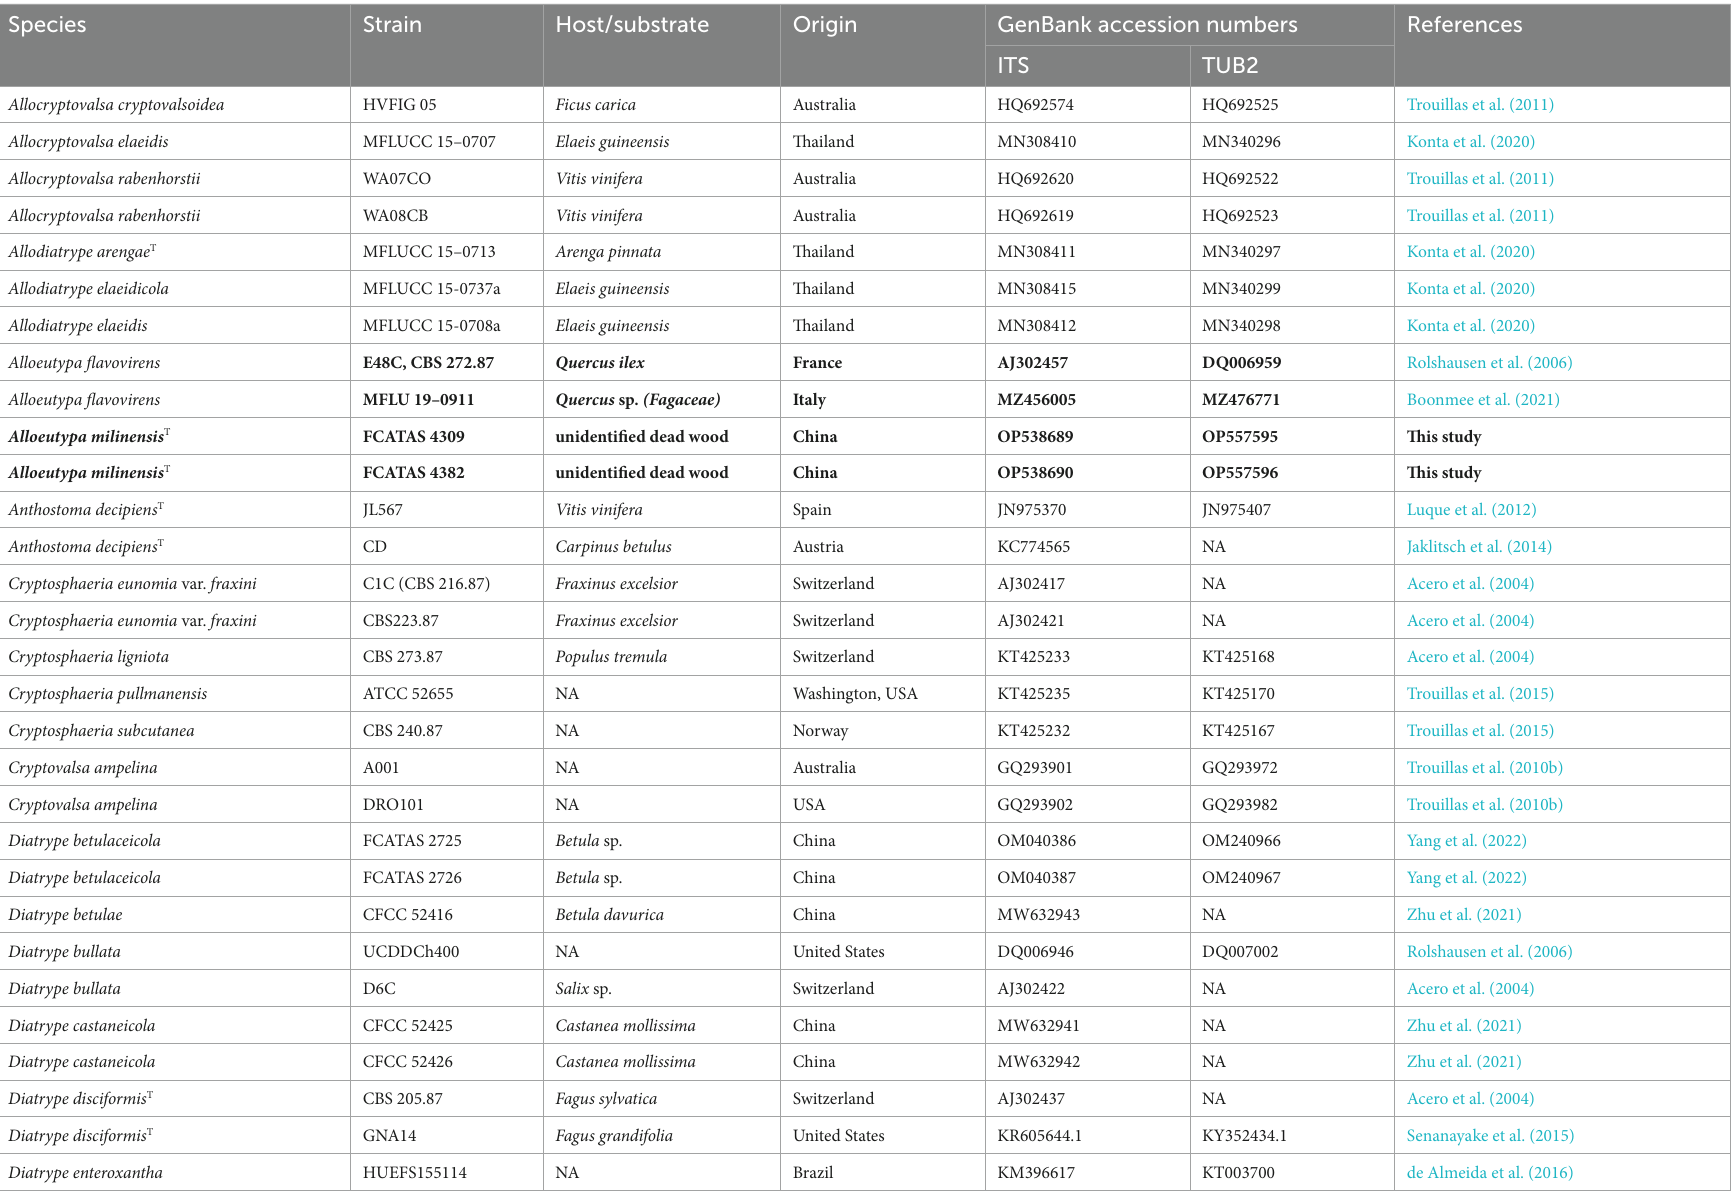
TABLE 1 List of species, specimens, and GenBank accession numbers of sequences used in this